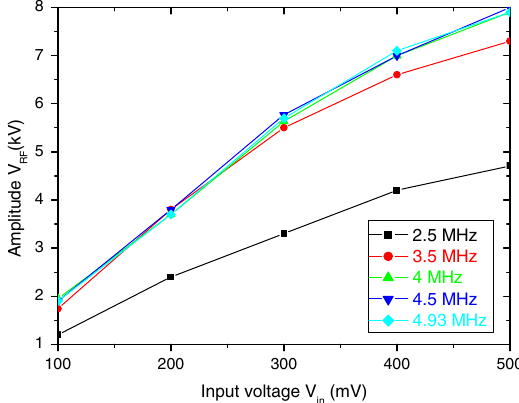
FIG. 5. Plot of the rf voltage amplitudes as a function of the input voltages for various frequencies set in the function gen- erator and for a configuration of eight turns per hollow coil.